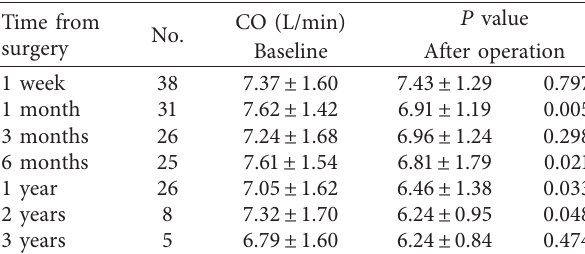
Table 4: Comparison of cardiac output (CO) at baseline and postoperatively in liver cirrhosis patients.